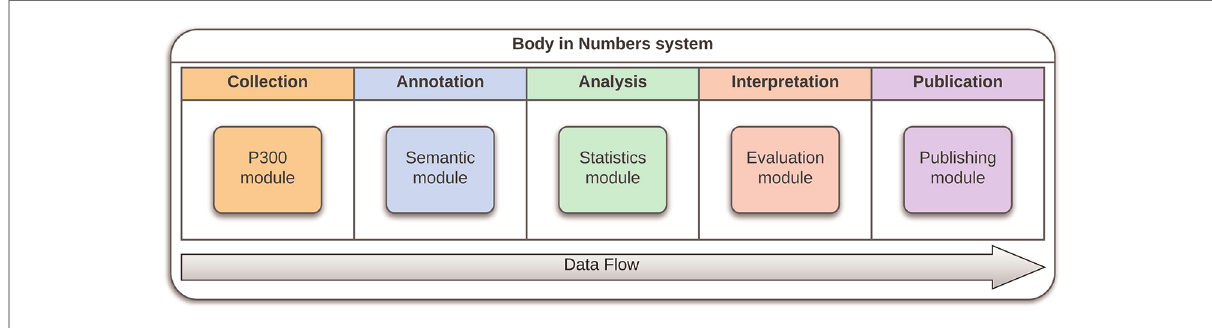
FIGURE 9 BiN lifecycle — For each of the data fl ow steps, module was developed that assisted with their respective tasks independently of the remaining